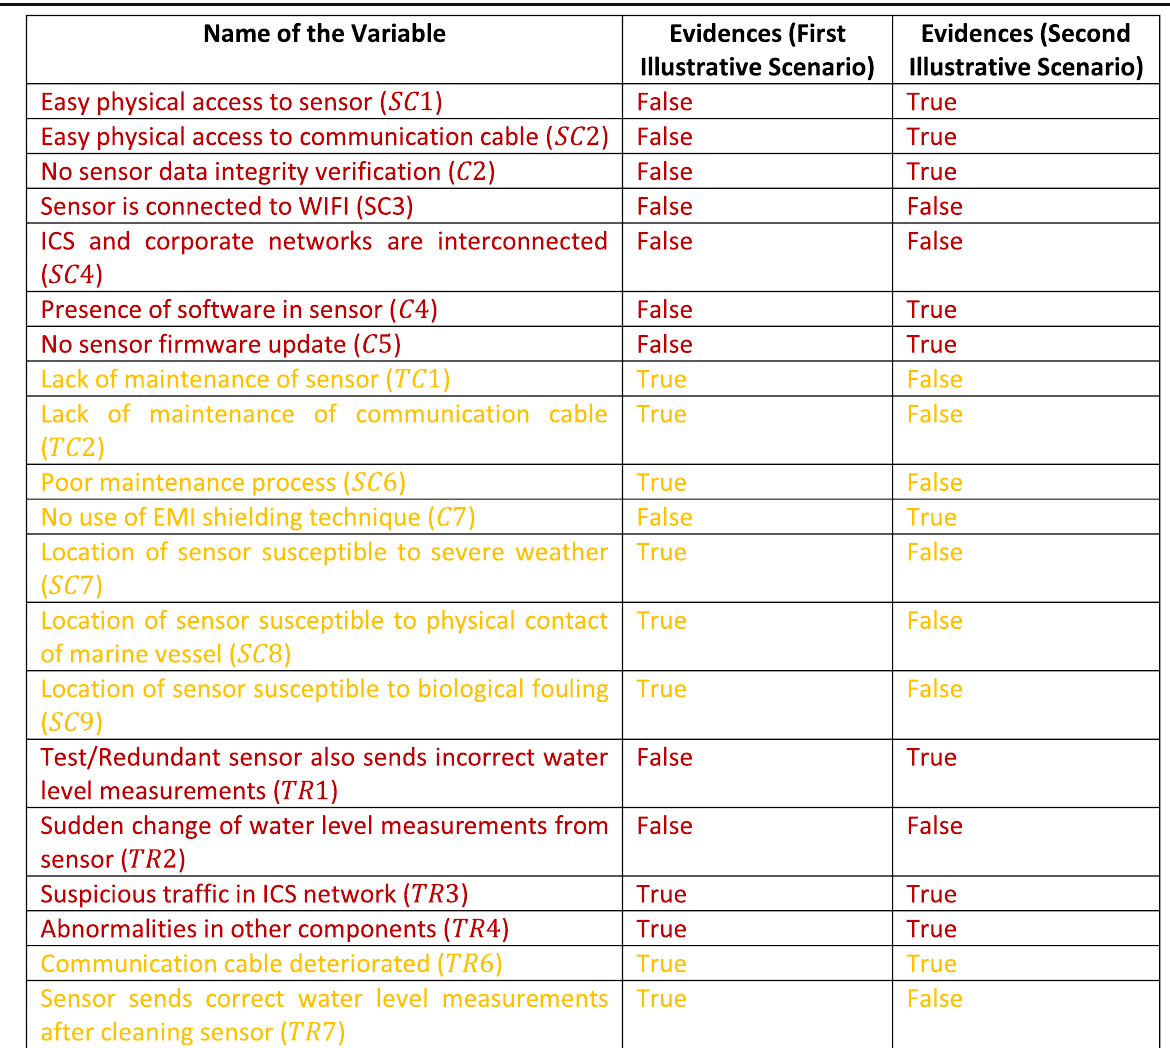
Table 3 Evidences Corresponding to both the Illustrative